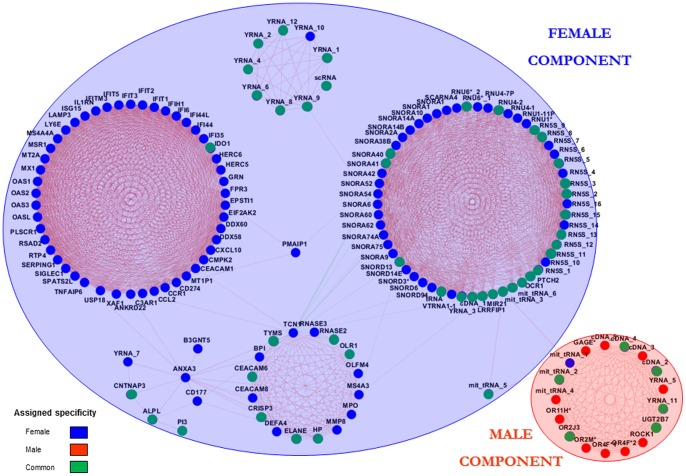
Results of the coexpression analysis performed on the 174 differentially expressed genes.The main component of the network is shown with a visualization of the specificities (female/male/common) previously assigned to the genes. Blue nodes: female genes; red nodes: male genes; green genes: common genes. Red edges: positive correlations; green edges: negative correlations.